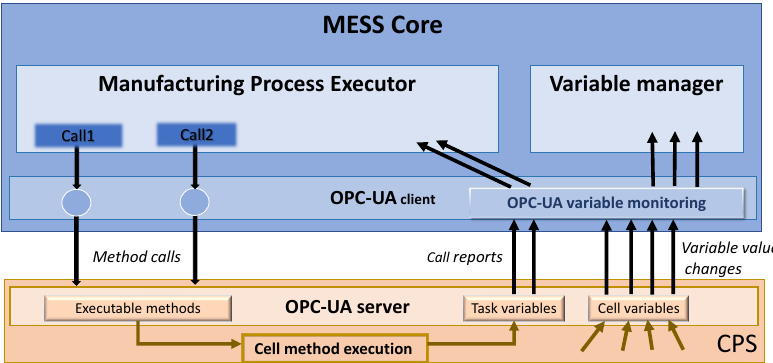
Figure 7. Details on the OPC UA interface between CPS and MESS Core.